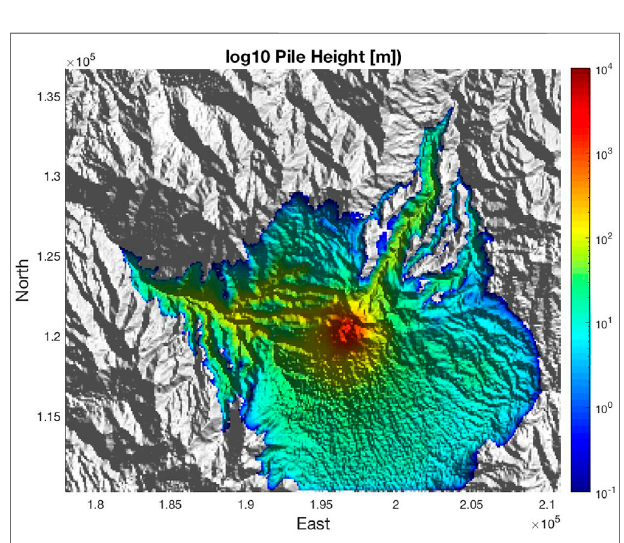
FIGURE 7 | Titan2D simulation of a fl ow at Azufral Volcano showing spread of fl ow widely in unchannelized areas, and con fi nement to valleys in channelized areas. Volume used similar to that of Espino and Cortadera fl ows in Figure 6 , producing similar runout distance or extent.